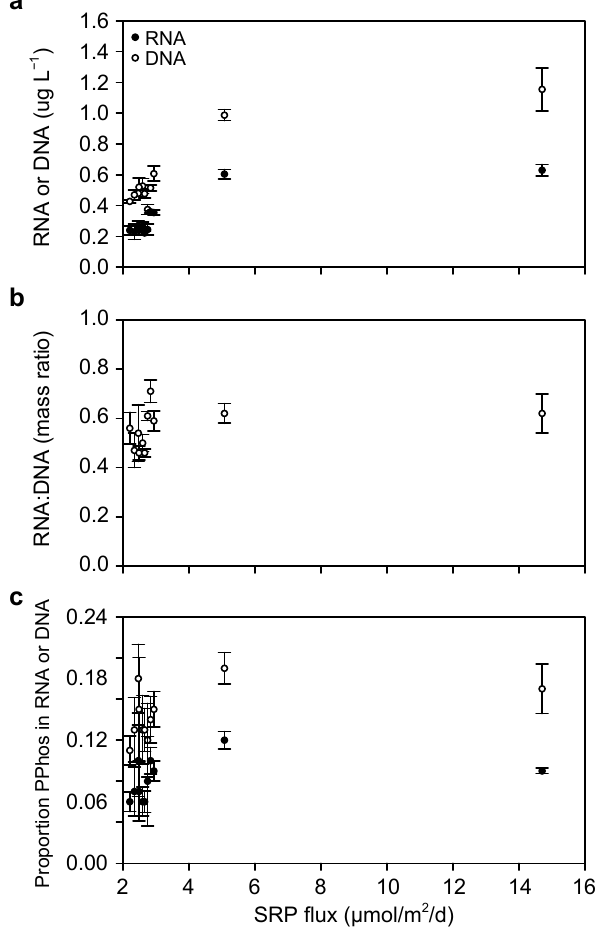
Fig. 6. Allocation to nucleic acids as a function of vertical flux of SRP across the BV47 transect (see Fig. 1). All points repre- sent means ± SE. All measurements of nucleic acids were signif- icantly correlated with SRP supply (Spearman rank correlations). (a) Concentrations (µgL − 1 ) of particulate RNA (filled circles, ρ =0.77, P=0.003) and DNA (open circles, ρ =0.69, P=0.012). (b) RNA:DNA mass ratios ( ρ =0.66, P=0.013). (c) The proportion of total PPhos bound in RNA ( ρ =0.57, P=0.034) or DNA ( ρ =0.51, P=0.054).